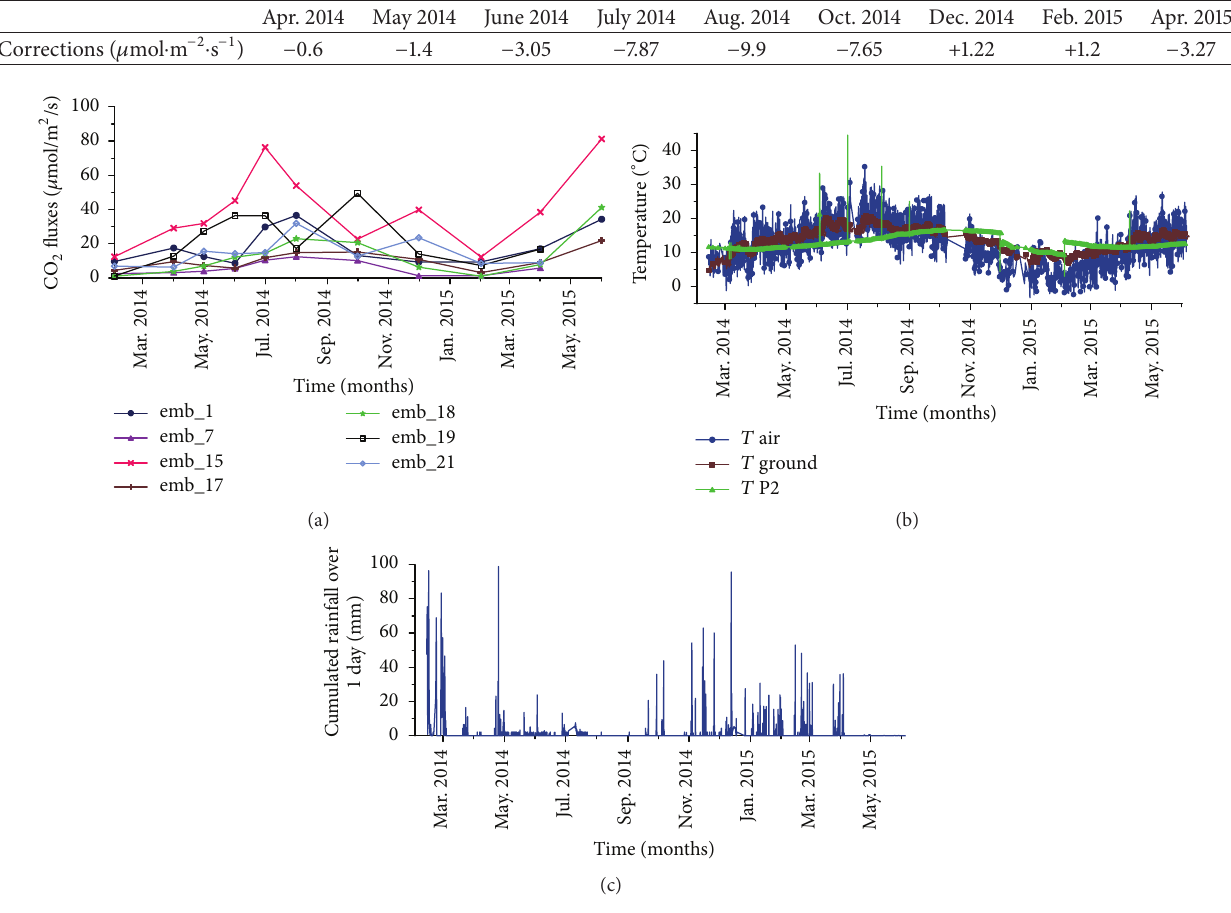
Figure 10: Measured CO 2 emissions (a); air, ground, and water temperatures (b); and rainfall (c) over time.